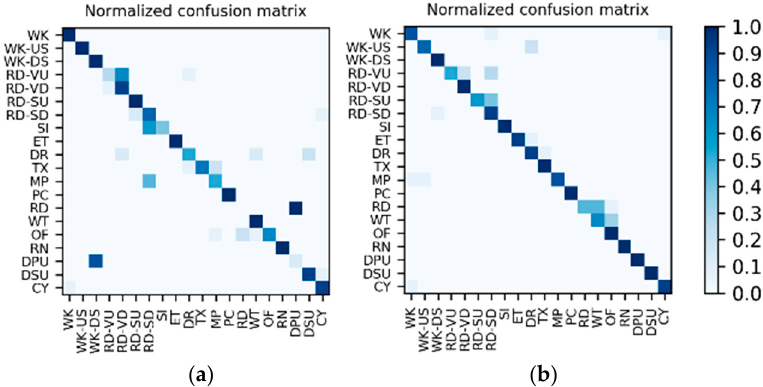
Figure 22. After hierarchical fusion, among the 10 splits, the confusion matrices with the ( a ) lowest accuracy and ( b ) highest accuracy. Table 15. Average F 1 accuracy of the 10 splits for each activity to be recognized.